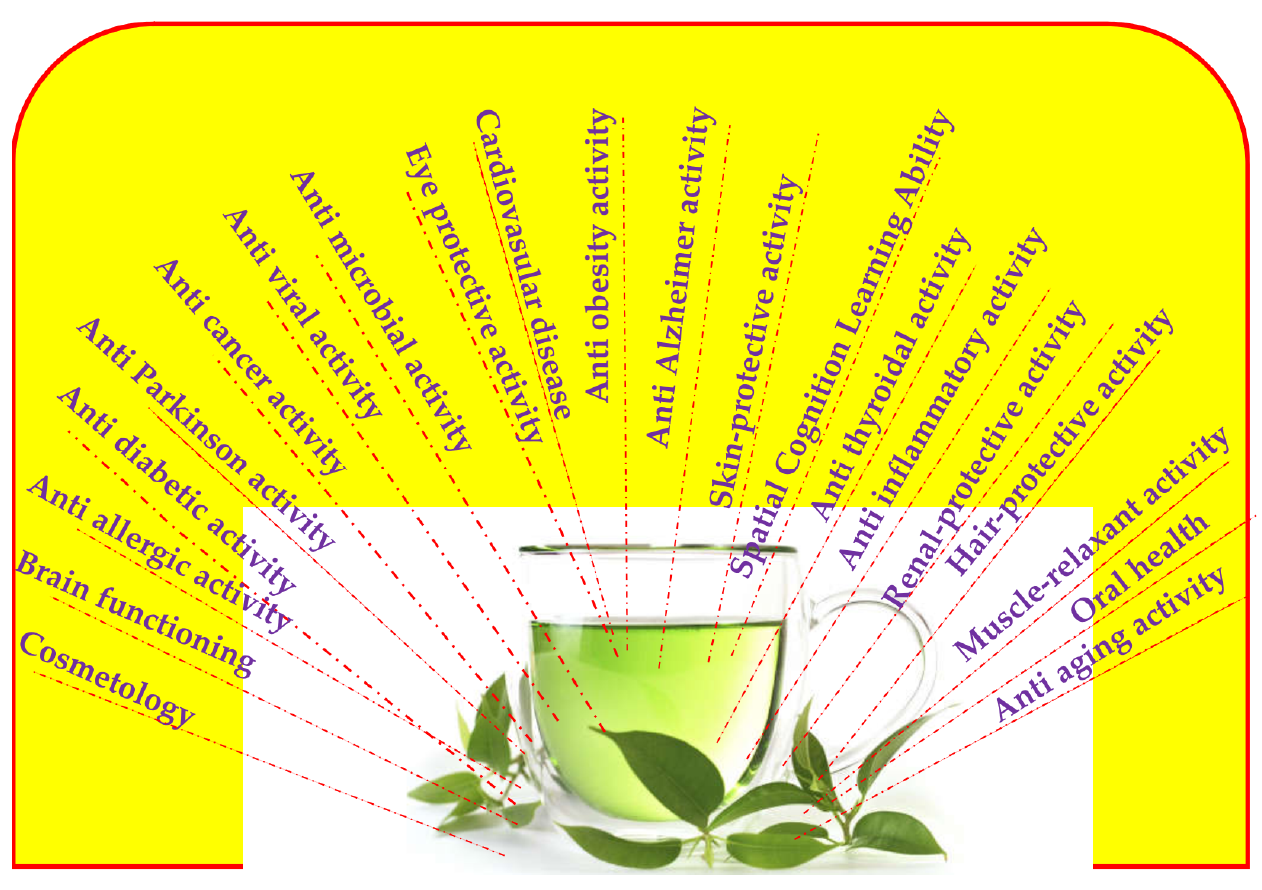
Figure 1. Overview of the health benefits of green tea.